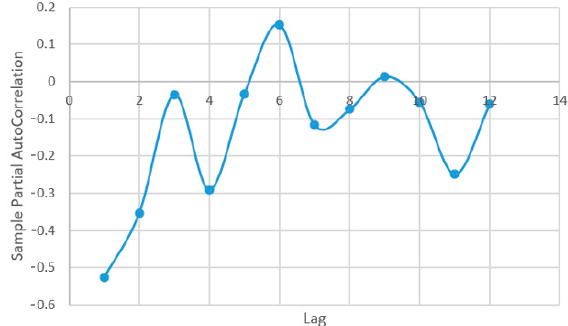
Figure A3. The AC with transformation in square roots—Series B.